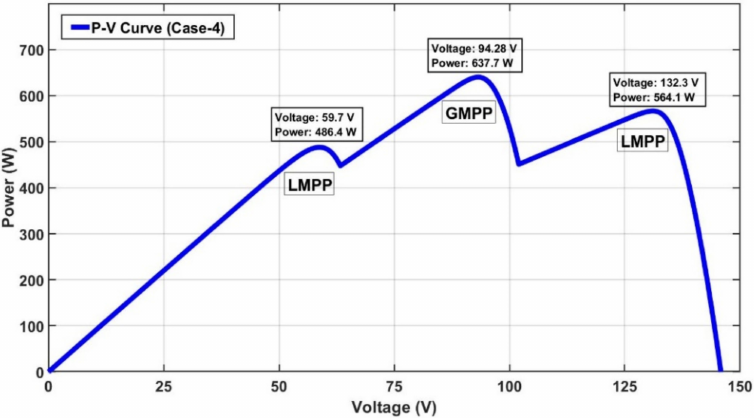
Figure 37. P-V curve